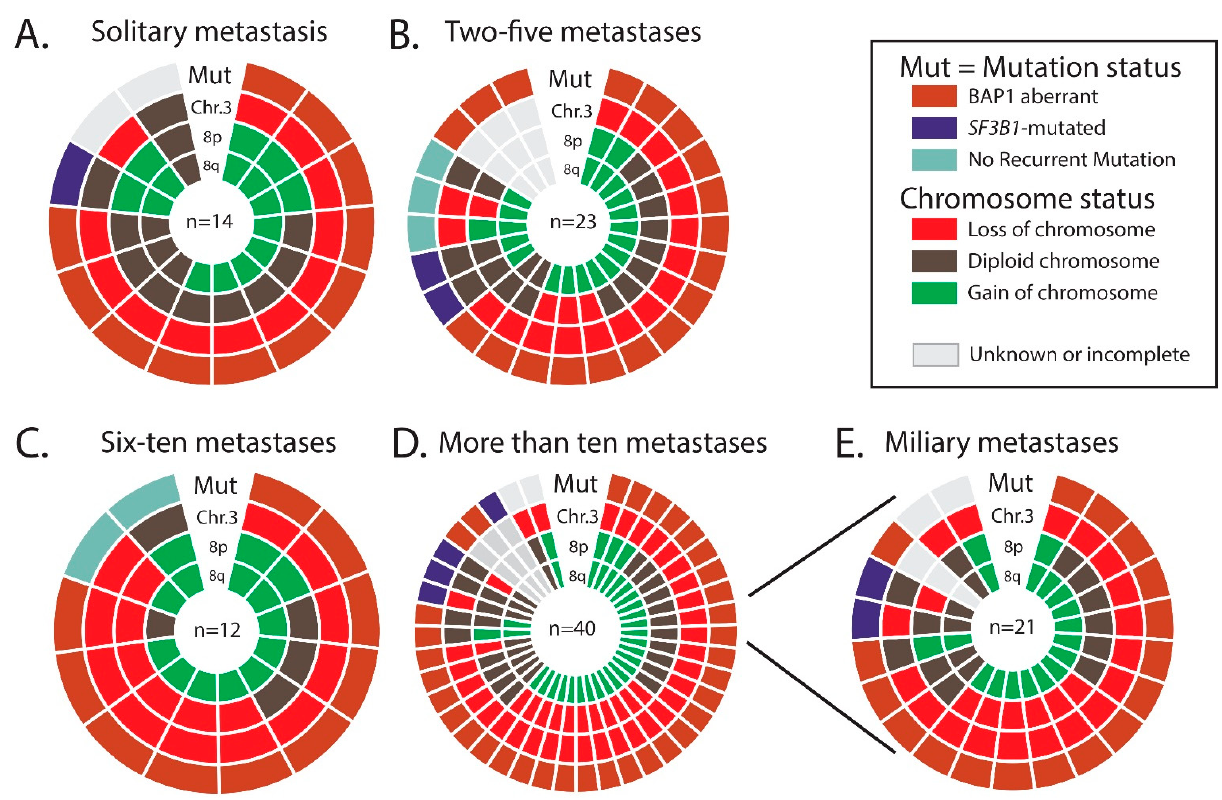
Figure 4. A doughnut chart with the mutation status of the prognostic relevant genes ( BAP1 , SF3B1 and No Recurrent Mutation), and aberrations of chromosome 3, 8p and 8q in the primary uveal melanomas, for respectively patients with ( A ) solitary metastases, ( B ) 2 to 5 metastases, ( C ) 6 to 10 metastases and ( D ) more than 10 metastases. ( D , E ) The distribution of the genetic abnormalities in patients who developed miliary metastases.